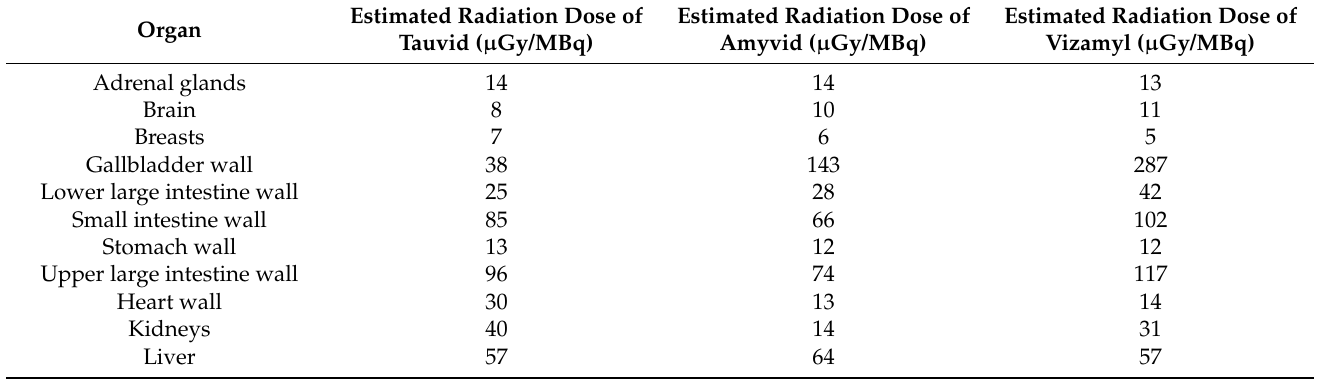
Table 1. Radiation dose estimates of Tauvid, Amyvid, and Vizamyl. *Assumed dose weighting factor of 1 for conver- sion of absorbed dose to dose equivalent for 18 F. To obtain radiation absorbed dose in rad/mCi, multiply the dose by 0.0037 = 0.0518 rad/mCi. Adapted from the labels of Tauvid [32], Amyvid [37], and Vizamyl